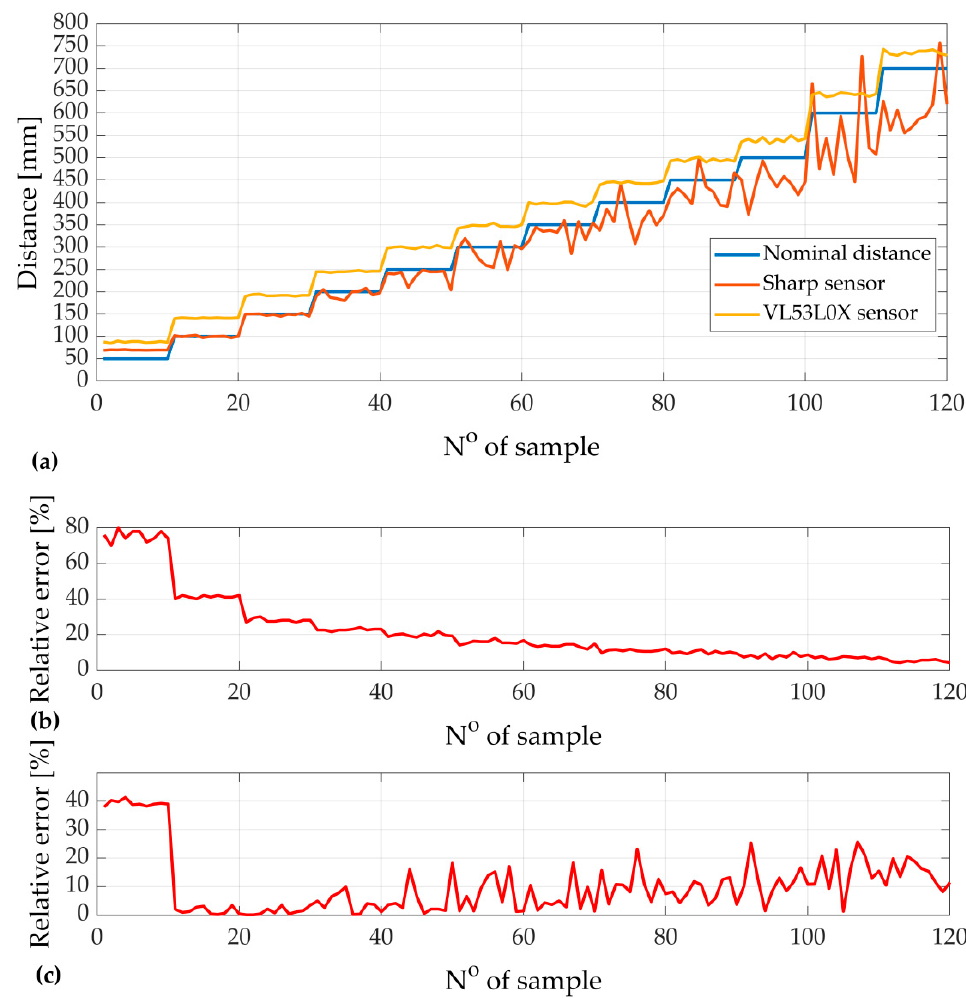
Figure 3. Measurement tests results: ( a ) comparison of applied sensors; ( b ) relative error for VL53L0X sensor; ( c ) relative error for Sharp sensor.